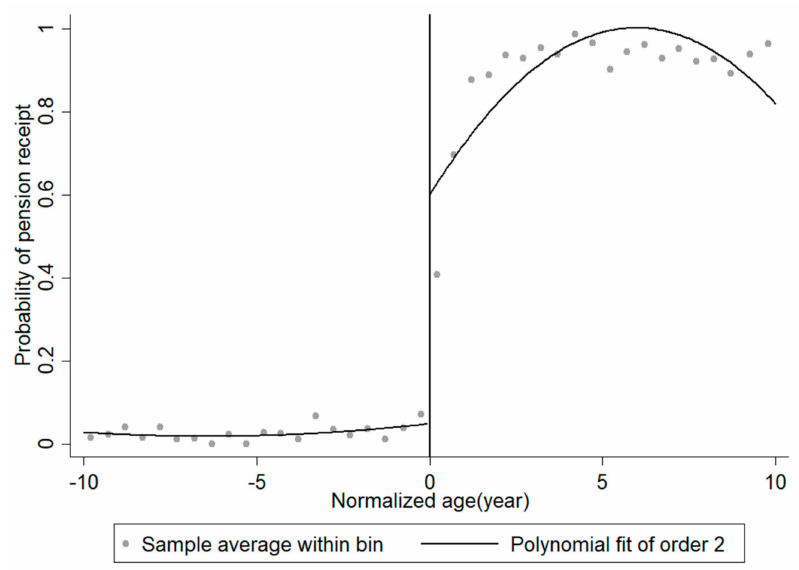
Figure 1. Pension receipt according to normalized age. Source: China Health and Retirement Longitudinal Survey (2015) [17]. Notes: Figure 1 describes the relationship between rate of pension receipt and respondents’ normalized age, using the sample of respondents aged between 50 and 70. The dots show the sample mean of the indicator variable for receiving a pension (1 if receiving pension, 0 otherwise) in each half year. The line is a polynomial fit of order